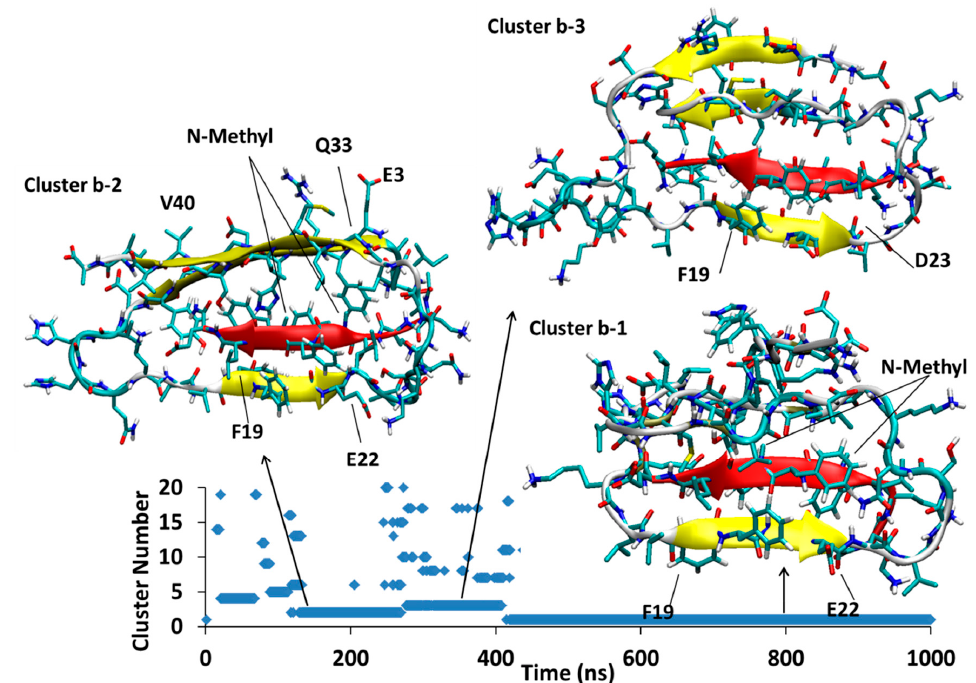
Figure 6. A β 42B -SGB1-b; Three major clusters are depicted; Cluster Bb1, Bb2 and Bb3. The vertical axis is the cluster number count based on population, where cluster 1 has the highest population. The horizontal axis is simulation time in nanoseconds.